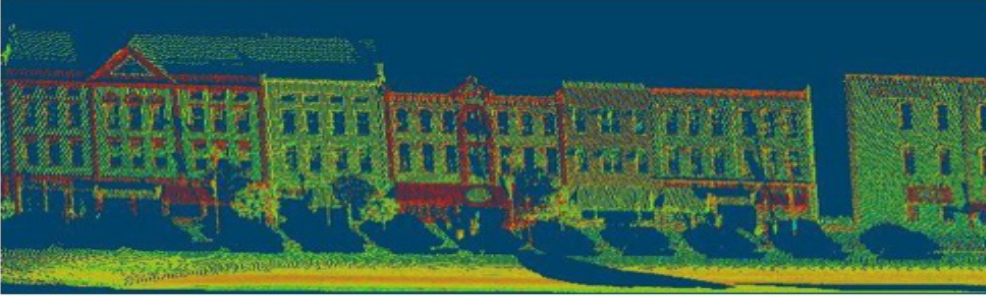
Figure 5. The objects classified as temporarily static and mobile are extracted out from the scene, leaving behind a perforated point cloud for each